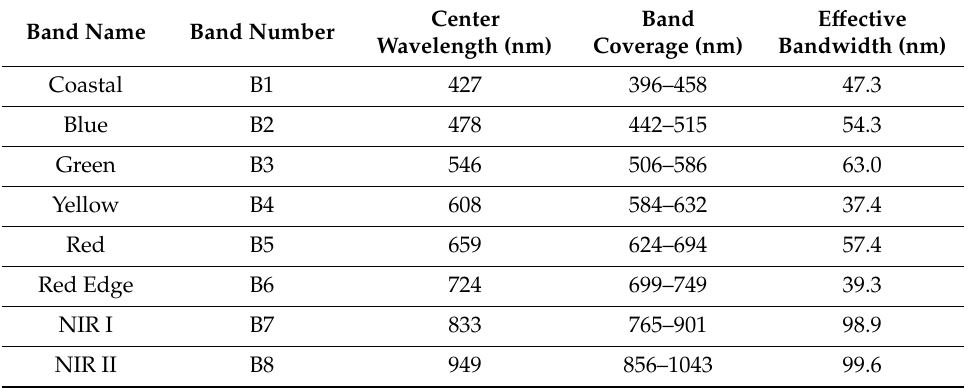
Table 1. WorldView-2 imagery specifications (NIR stands for near-infrared; Digital Globe ™ ,